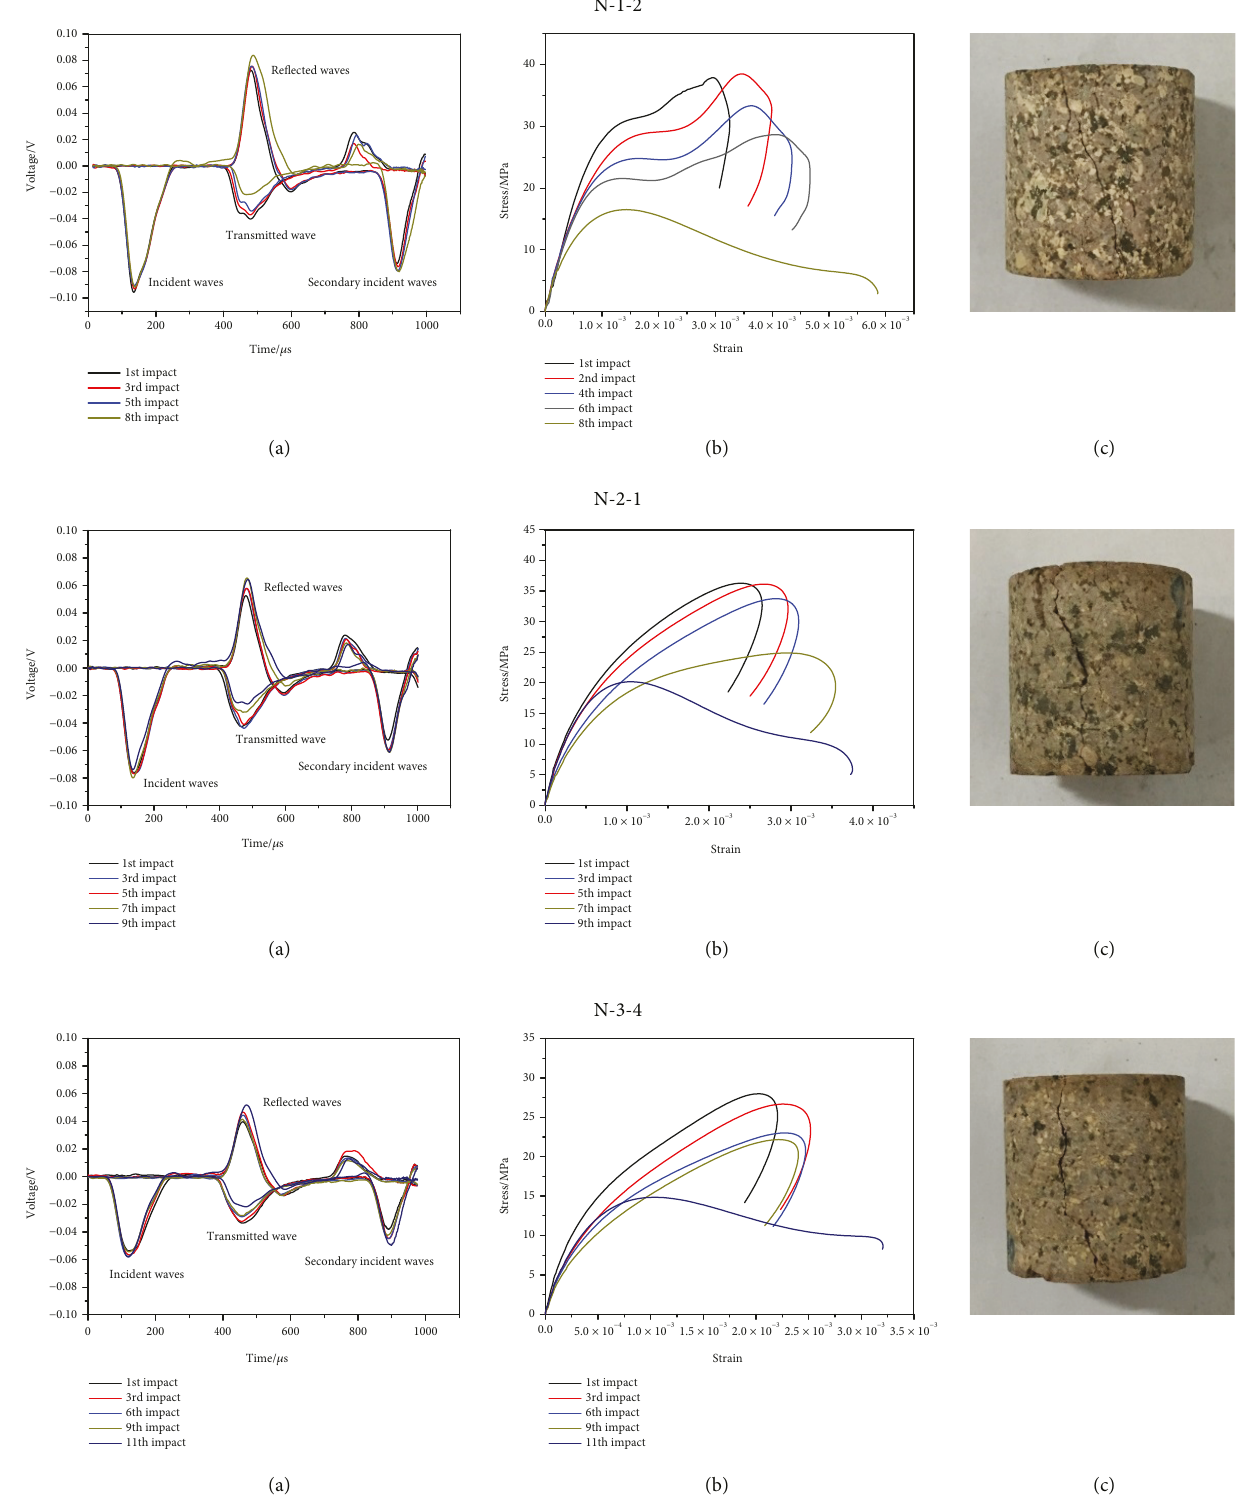
Figure 8: Dynamic response of weakly weathered granites under cyclic impacts of approximately constant velocity: (a) strain signal waveform, (b) stress-strain curve, and (c) failure